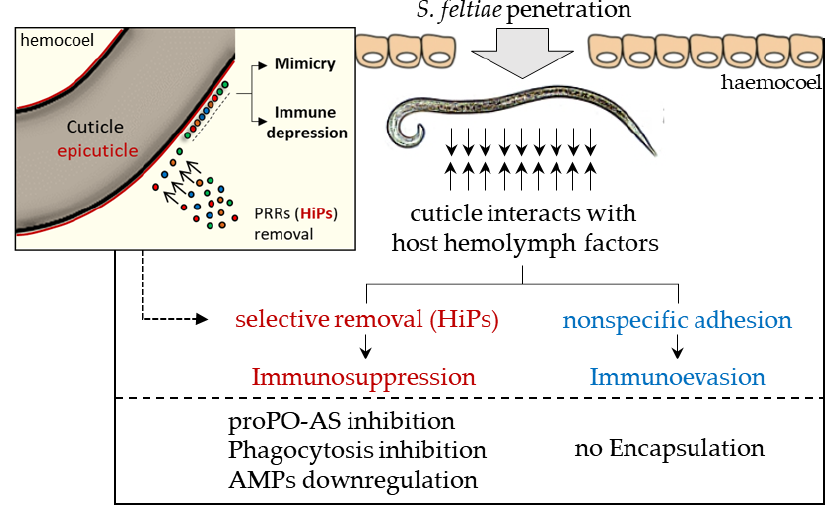
Figure 16. Schematic model of the effects of S. feltiae after penetration in insect host. Cuticle compounds remove host humoral factor, inducing immune evasion and depression; particularly, the specific interaction of cuticle lipids results in a selective subtraction of host PRRs (HiPs) leading to a general immune suppression. In addition, the coating of the parasite with host compounds is responsible of its mimicry properties.